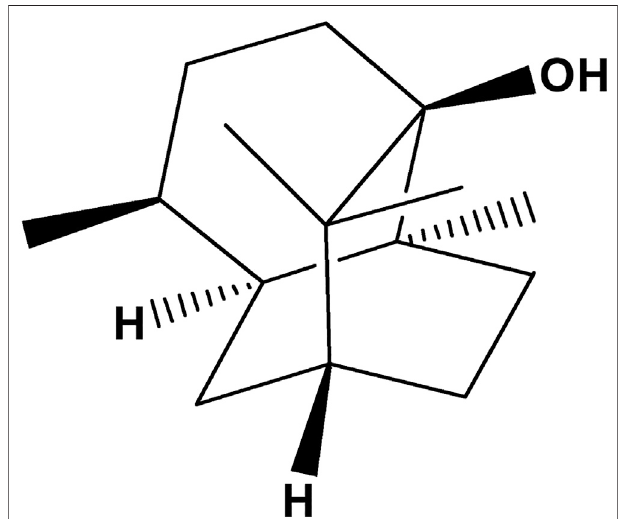
FIGURE 1 | Chemical structure of